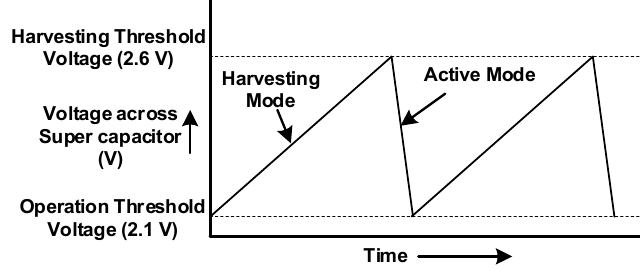
Figure 5. Voltage across supercapacitor and switching between modes. 288